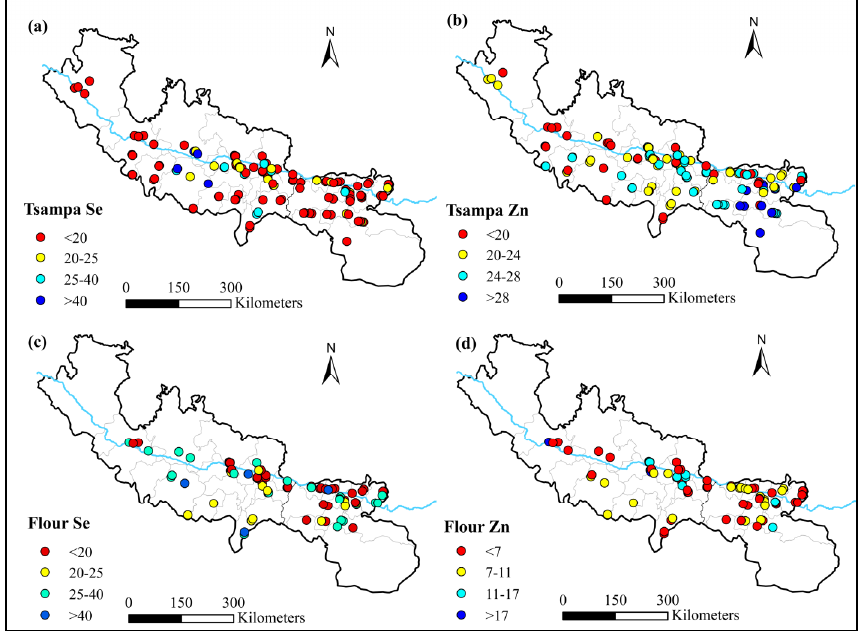
Figure 4. Spatial distribution of Se (µg·kg −1 ) and Zn (mg·kg −1 ) concentrations of staple grains. ( a ) Spatial distribution of Se (µg·kg −1 ) concentration of tsampa; ( b ) spatial distribution of Zn (mg·kg −1 ) concentration of tsampa; ( c ) spatial distribution of Se (µg·kg −1 ) concentration of flour; ( d ) spatial distribution of Zn (mg·kg −1 ) concentration of flour.